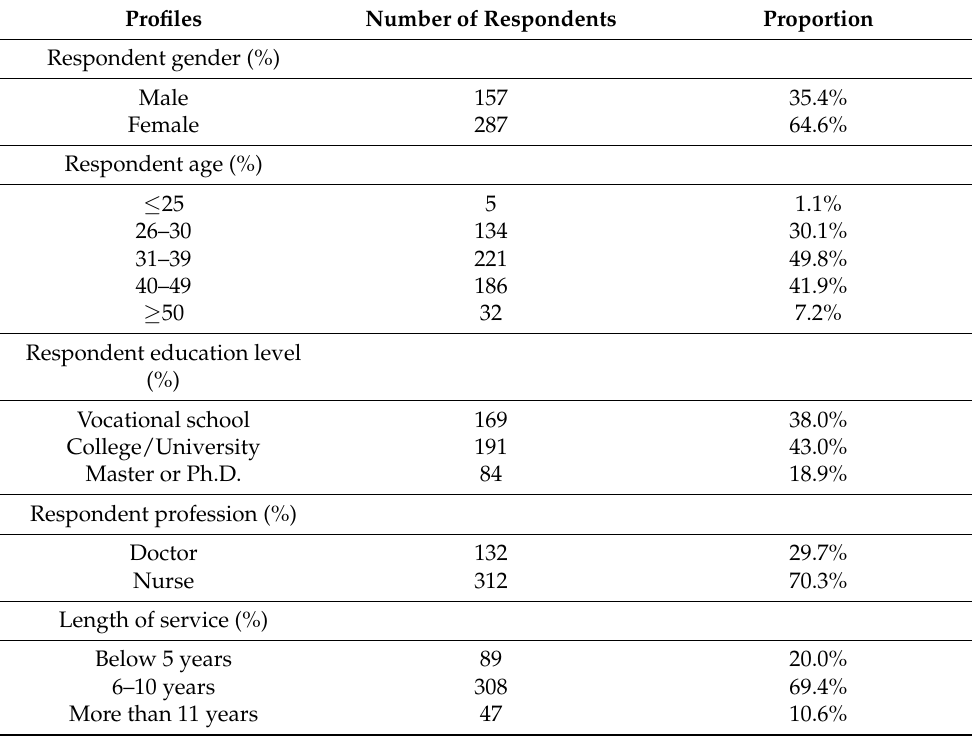
Table 1. Demographic profile of the survey participants (N =